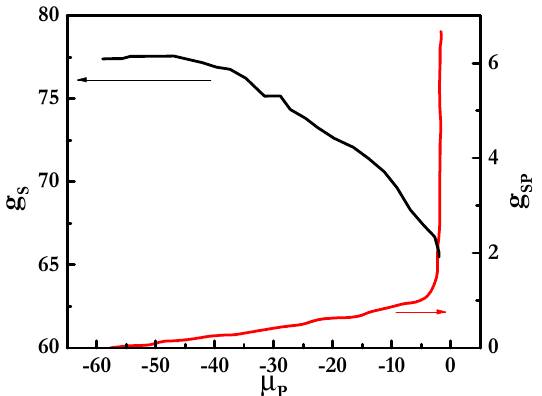
Figure 8. Dependences of the aggregation number of surfactants in the complexes ( g s , left axis) and the degree of polyelectrolyte–surfactant binding ( g PS , right axis) on µ P for mixtures of PDADMAC with di-RL.